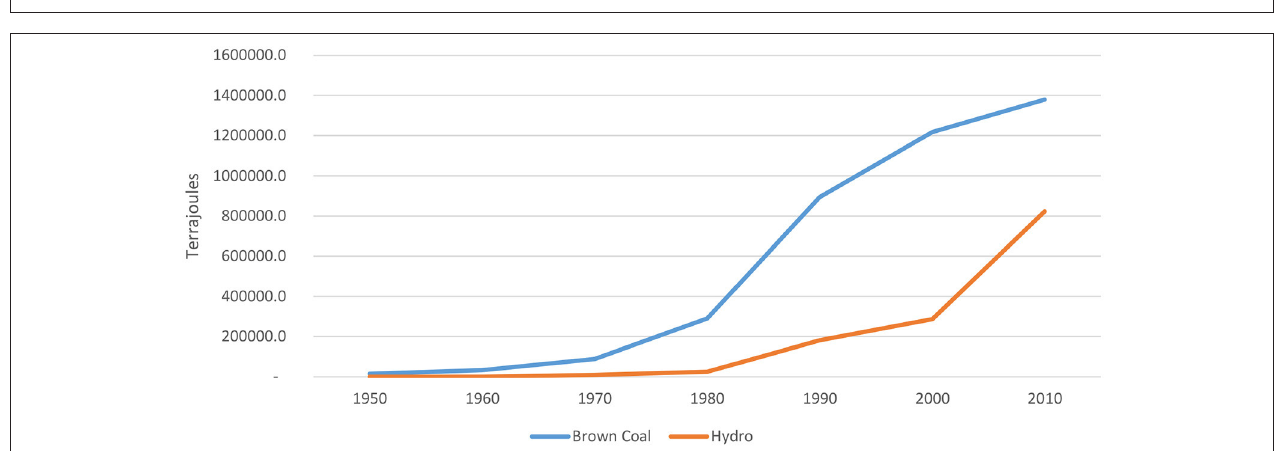
FIGURE 1 | Map of Environmental Justice in Turkey (Özkaynak et al., 2015a).